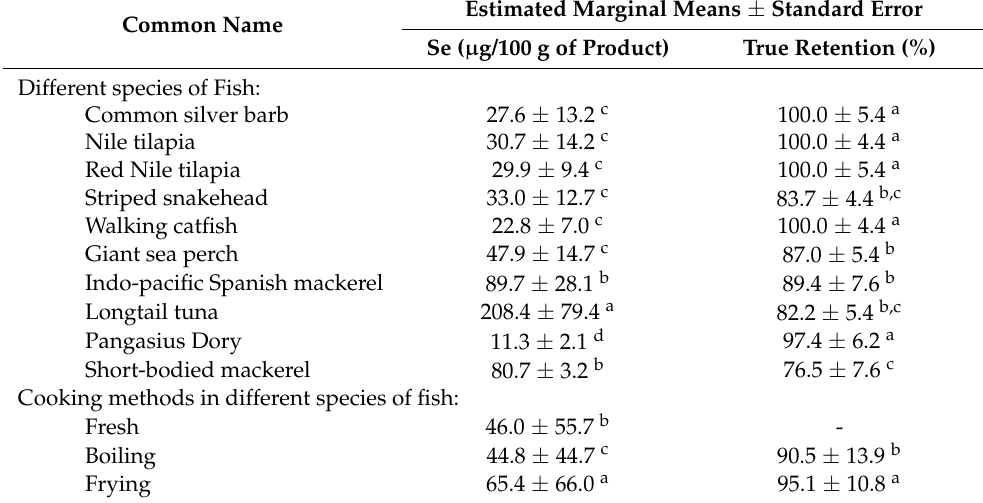
Table 6. Estimated marginal means of Se concentration and percentage of Se true retention by the main effects of different species of fish and cooking methods (calculated from two-way ANOVA) ( n =